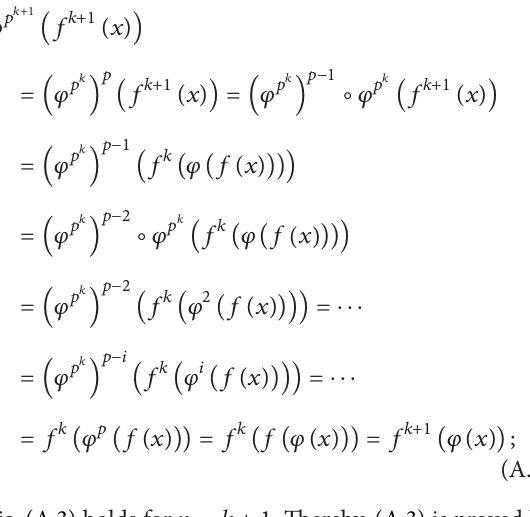
Obviously, 𝜑 0 satisfies the conditions of Theorem 8 with 𝑝 = 3 , 𝑓(𝑥) = 𝑥 2 /5 , and 𝜆 = 𝑓(1) = 1/5, 𝛼 = 2/5 . Hence it is the restriction to [1/5, 1] of a single-valley-extended continuous solution 𝜑 to (4). Since 𝜑 0 has the minimum point 𝛼 = 2/5 and 𝜑 0 (1/5) = 109/125 > 2/5 , 𝜑 2 0 (1/5) = 59/125 > 2/5 , 𝜑 is a single-valley-extended non-single-valley continuous solution. Its graph is similar to Figure